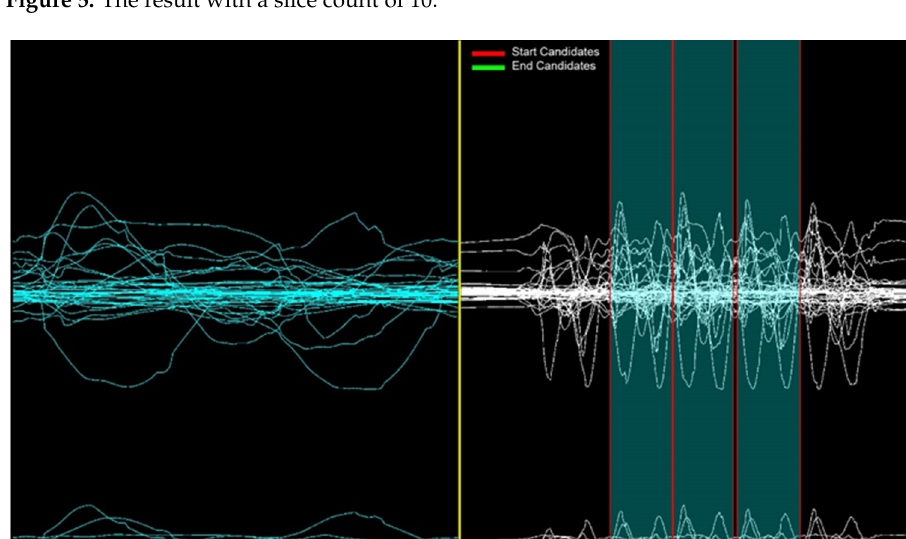
Figure 6. The result with a slice count of 25.